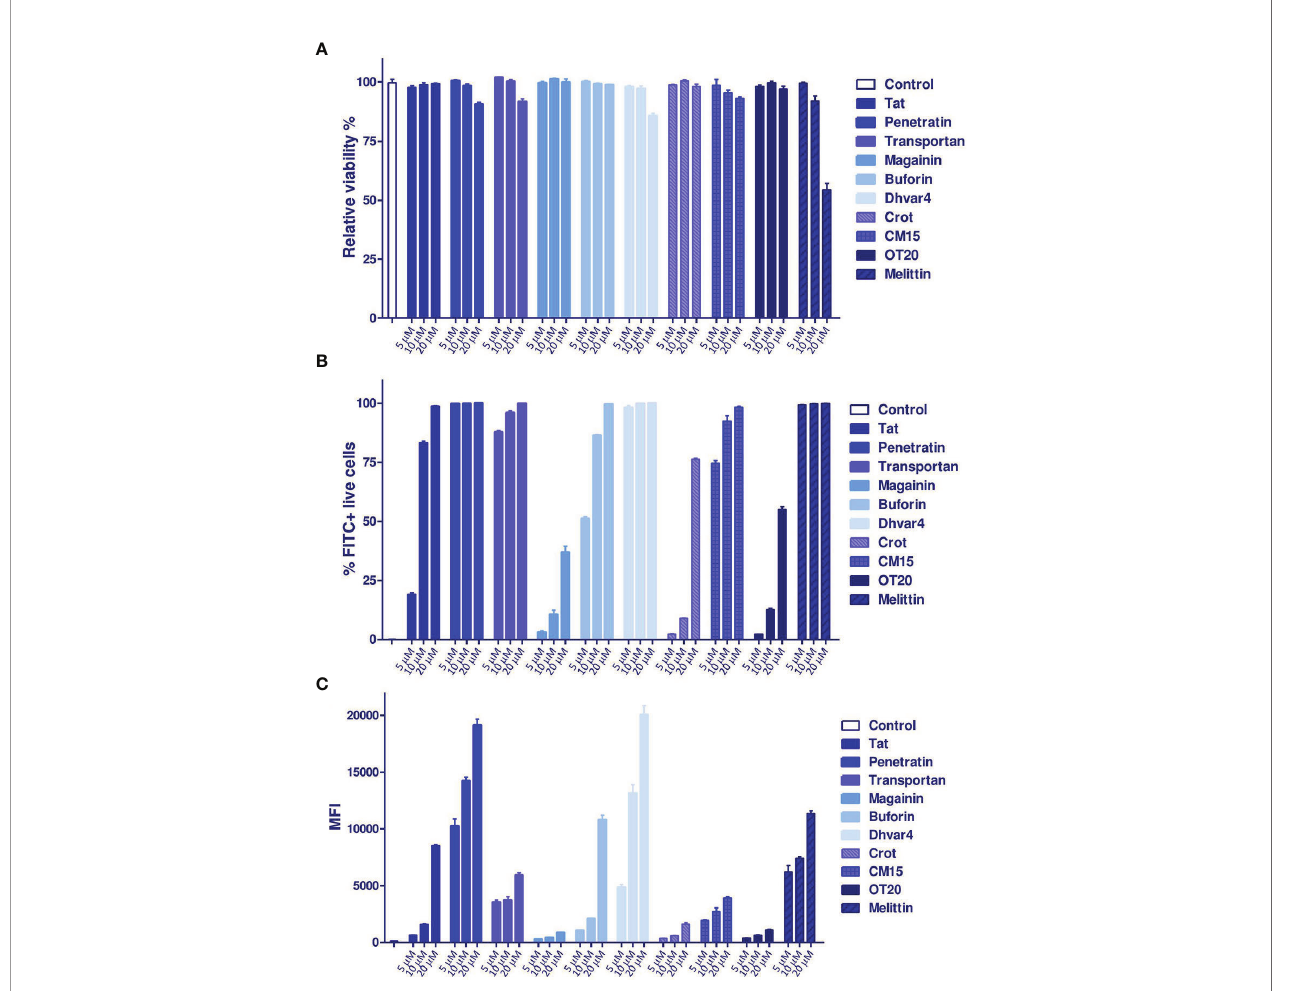
FIGURE 5 | Internalization of Cf -labeled peptides to MonoMac-6 human monocytes. Cells were treated with the peptides for 2 h, then after trypsinization, the internalization rate was measured by a BD LSR II fl ow cytometer. (A) The relative viability of the cells compared with the medium-treated control cells. The percentage of FITC ( Cf )-positive cells is presented in (B) , while the mean fl uorescent intensity (MFI) is shown in (C) . Bars represent the mean of three parallels ± SEM. For analysis of statistical signi fi cance, unpaired t -test was